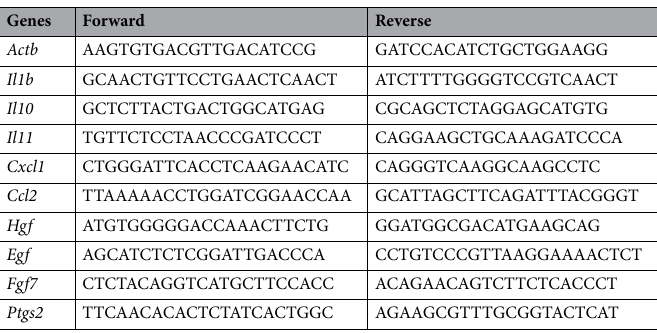
Table 2. List of real-time PCR